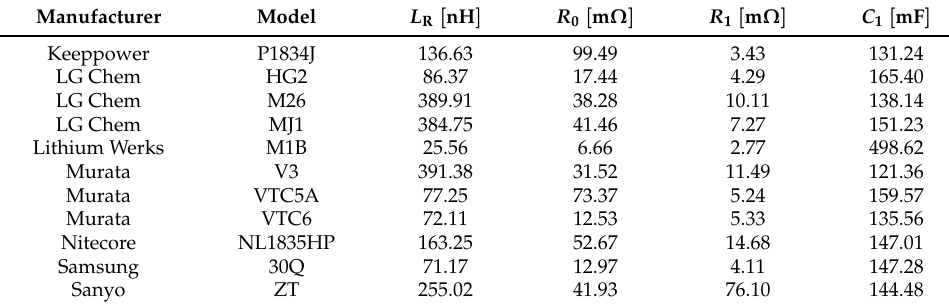
Table 5. Estimated battery parameters for the one- RC -pair